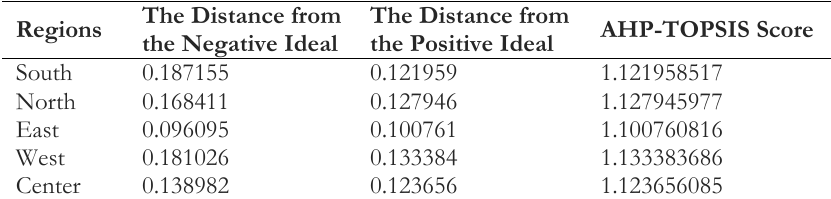
Table 9. The results of AHP-TOPSIS hybrid method.